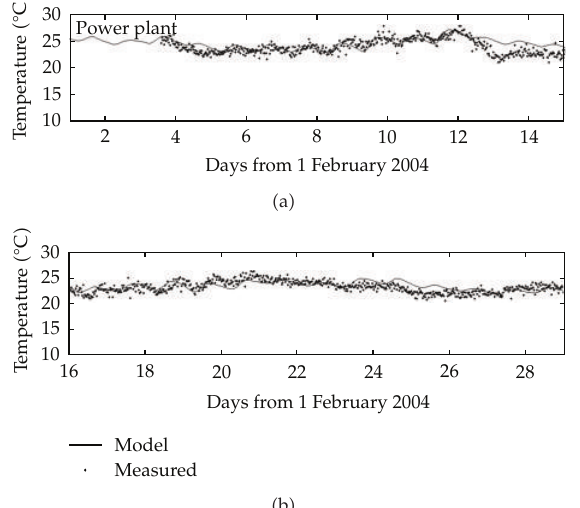
Figure 7: Comparison of the measured and modeled water temperature in power plant station from February